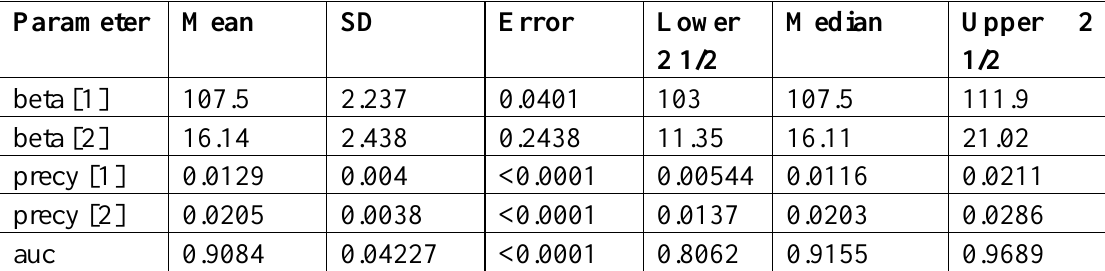
Table 9. Posterior distribution for the ROC area.